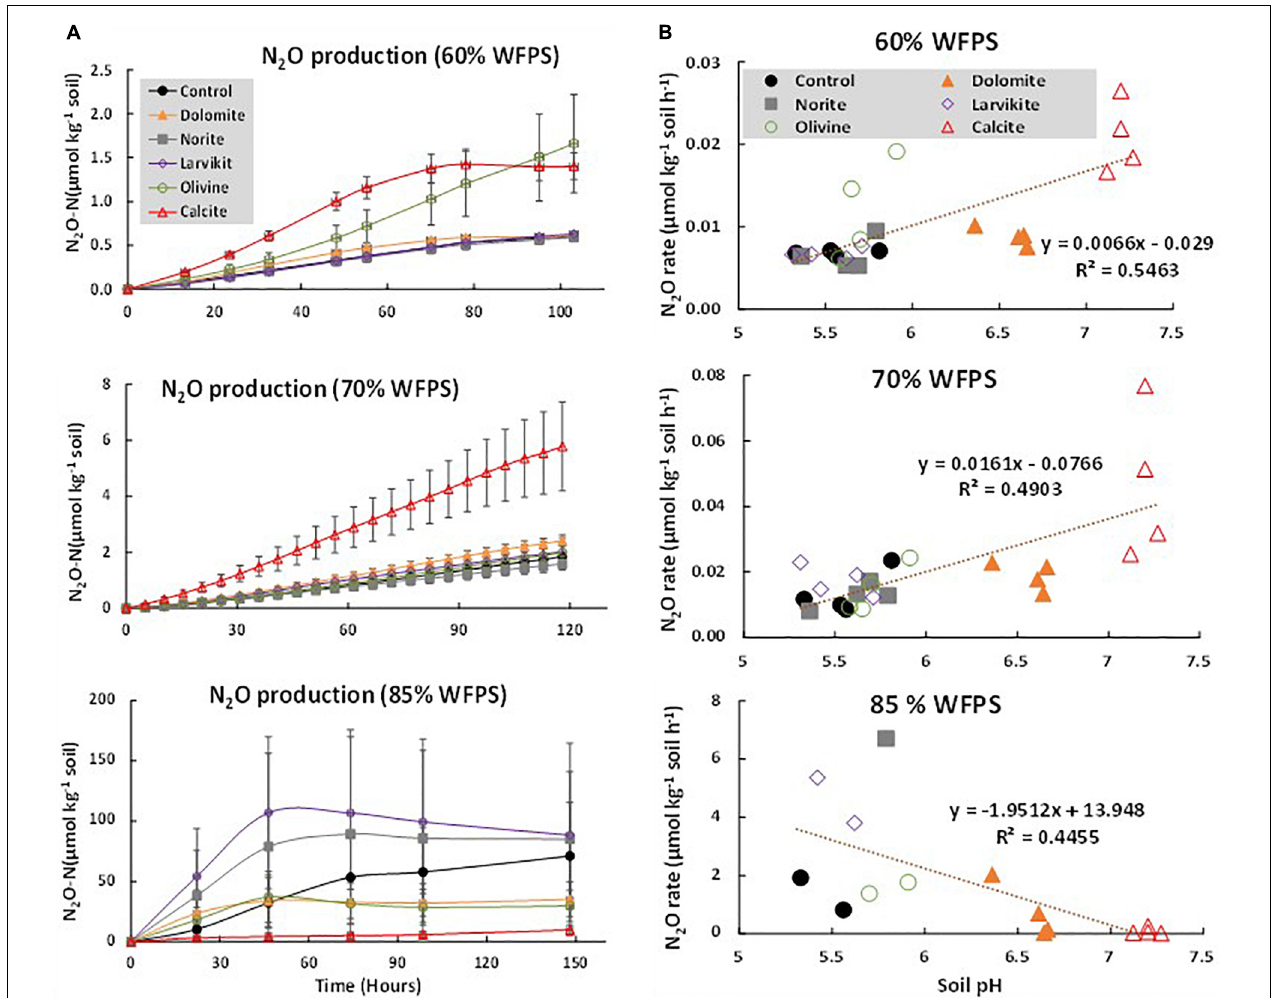
FIGURE 5 | N 2 O accumulation during oxic incubations of remolded soils amended with NH 4 + . Panel (A) shows the N 2 O kinetics throughout the incubations at the three moisture levels (means and standard error, n = 4). Panel (B) shows the N 2 O production rates during the first 50 h of incubation plotted against the pH of the soils (individual flasks). Soils were collected from the field 15 months after liming (December 2015) for the 60% WFPS experiment and 27 months after liming (December 2016) for the 70 and 85% WFPS experiment. The NO 2 - + NO 3 - accumulation throughout the incubations at 60 and 85% WFPS are shown in Supplementary Figure 6